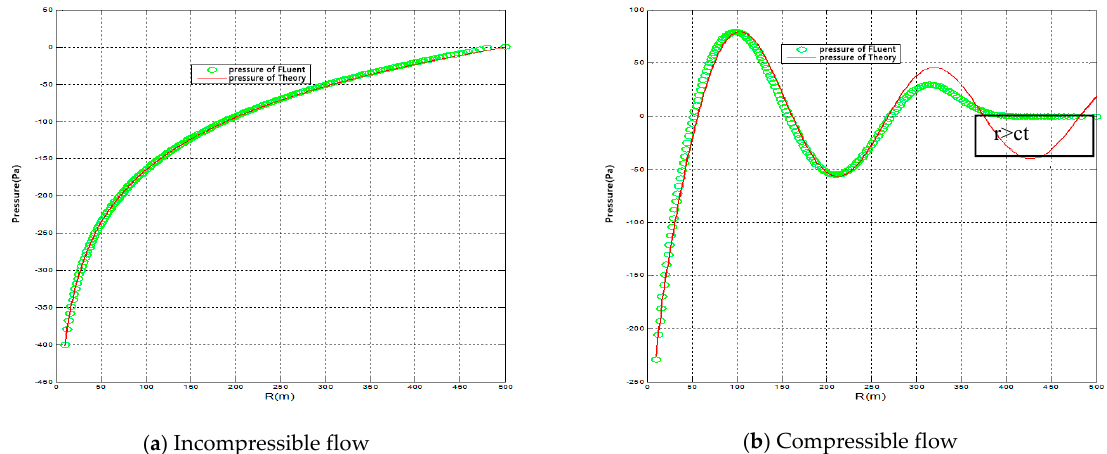
Figure 3. Validation of the velocity vs radius when t = 1.0 s.